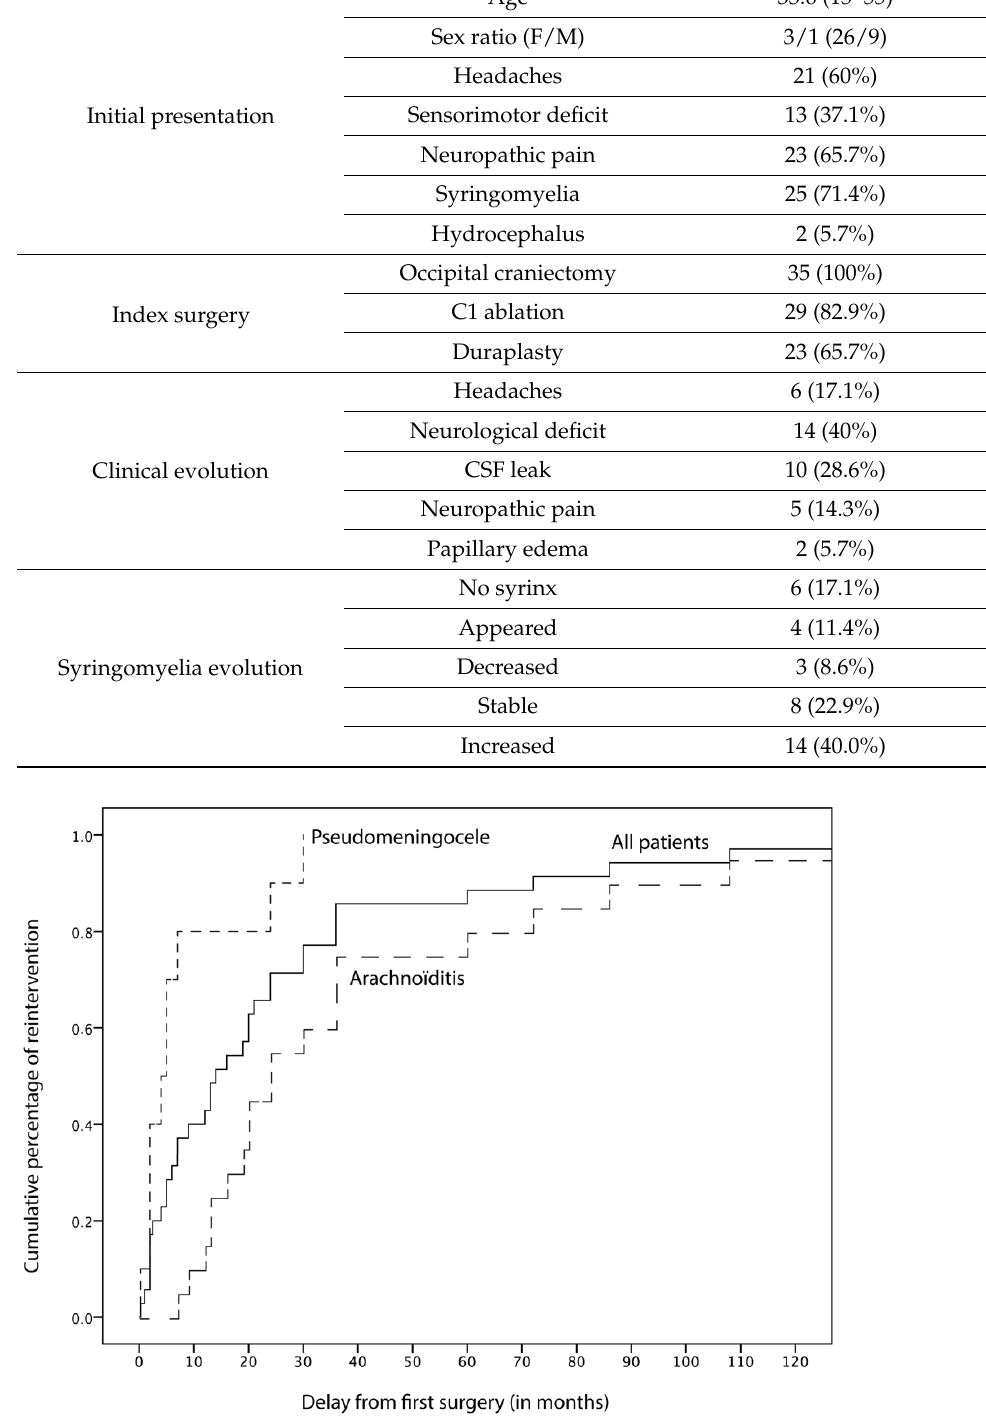
Figure 2. Craniovertebral junction revision after Chiari decompression failure. Case of a 39 years- old female patient initially operated on at another center for a Chiari I malformation without syrin- gomyelia before index decompression surgery ( A ). Foraminal arachnoiditis and progressing syrin- gomyelia ( B ), syringobulbia ( C ) and no CSF flow at the craniovertebral junction ( D ) 7 years postop- eratively. CVJ revision was performed: bone decompression was enlarged, duraplasty was re- moved, and tonsilles were coagulated allowing resolution of the syringomyelia at 1 year postoper- ative ( E ).